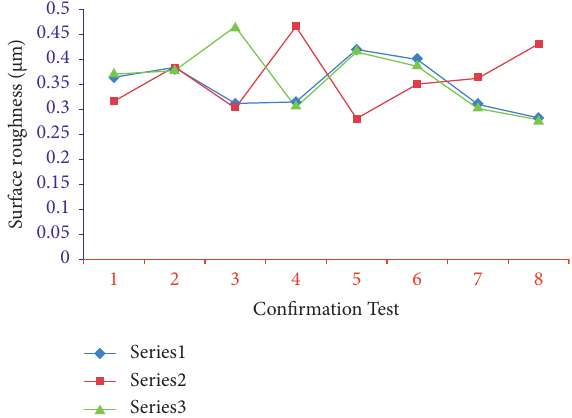
Figure 11: Comparison of predicted and experimental surface roughness values.